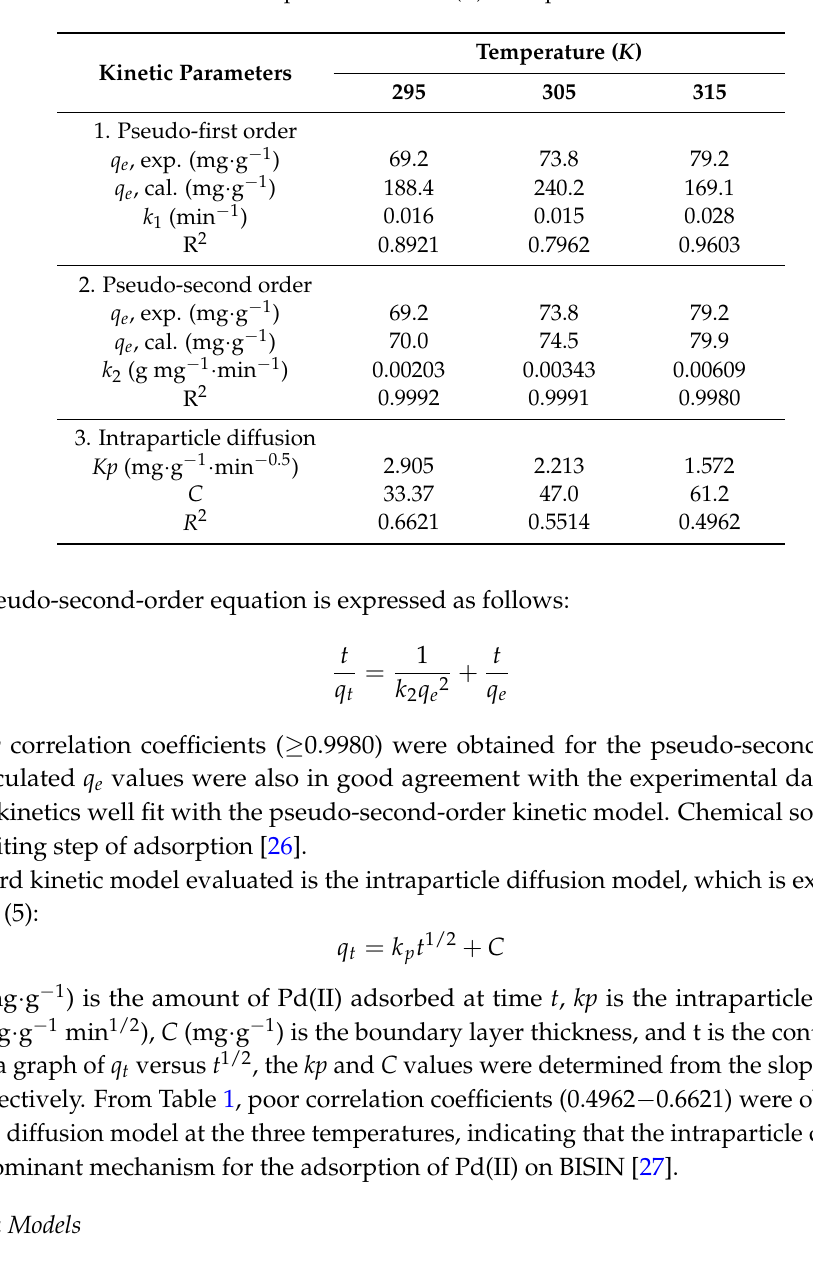
Table 1. Kinetic parameters of Pd(II) adsorption onto